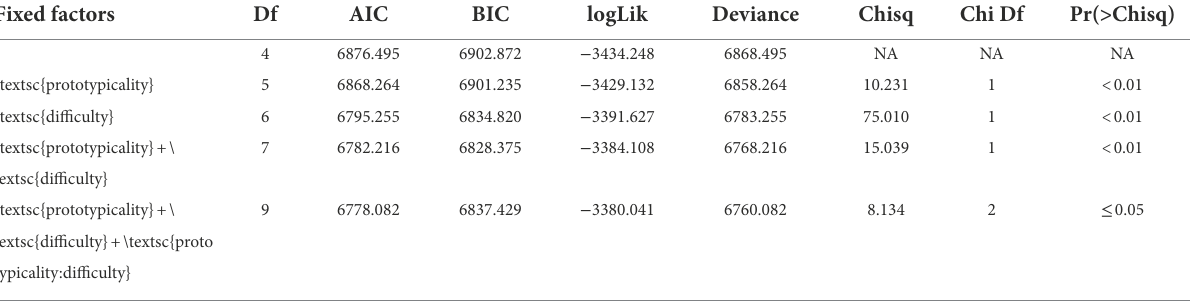
TABLE 4 The criteria used to compare the candidate models for the response accuracy dataset in Experiment 2.